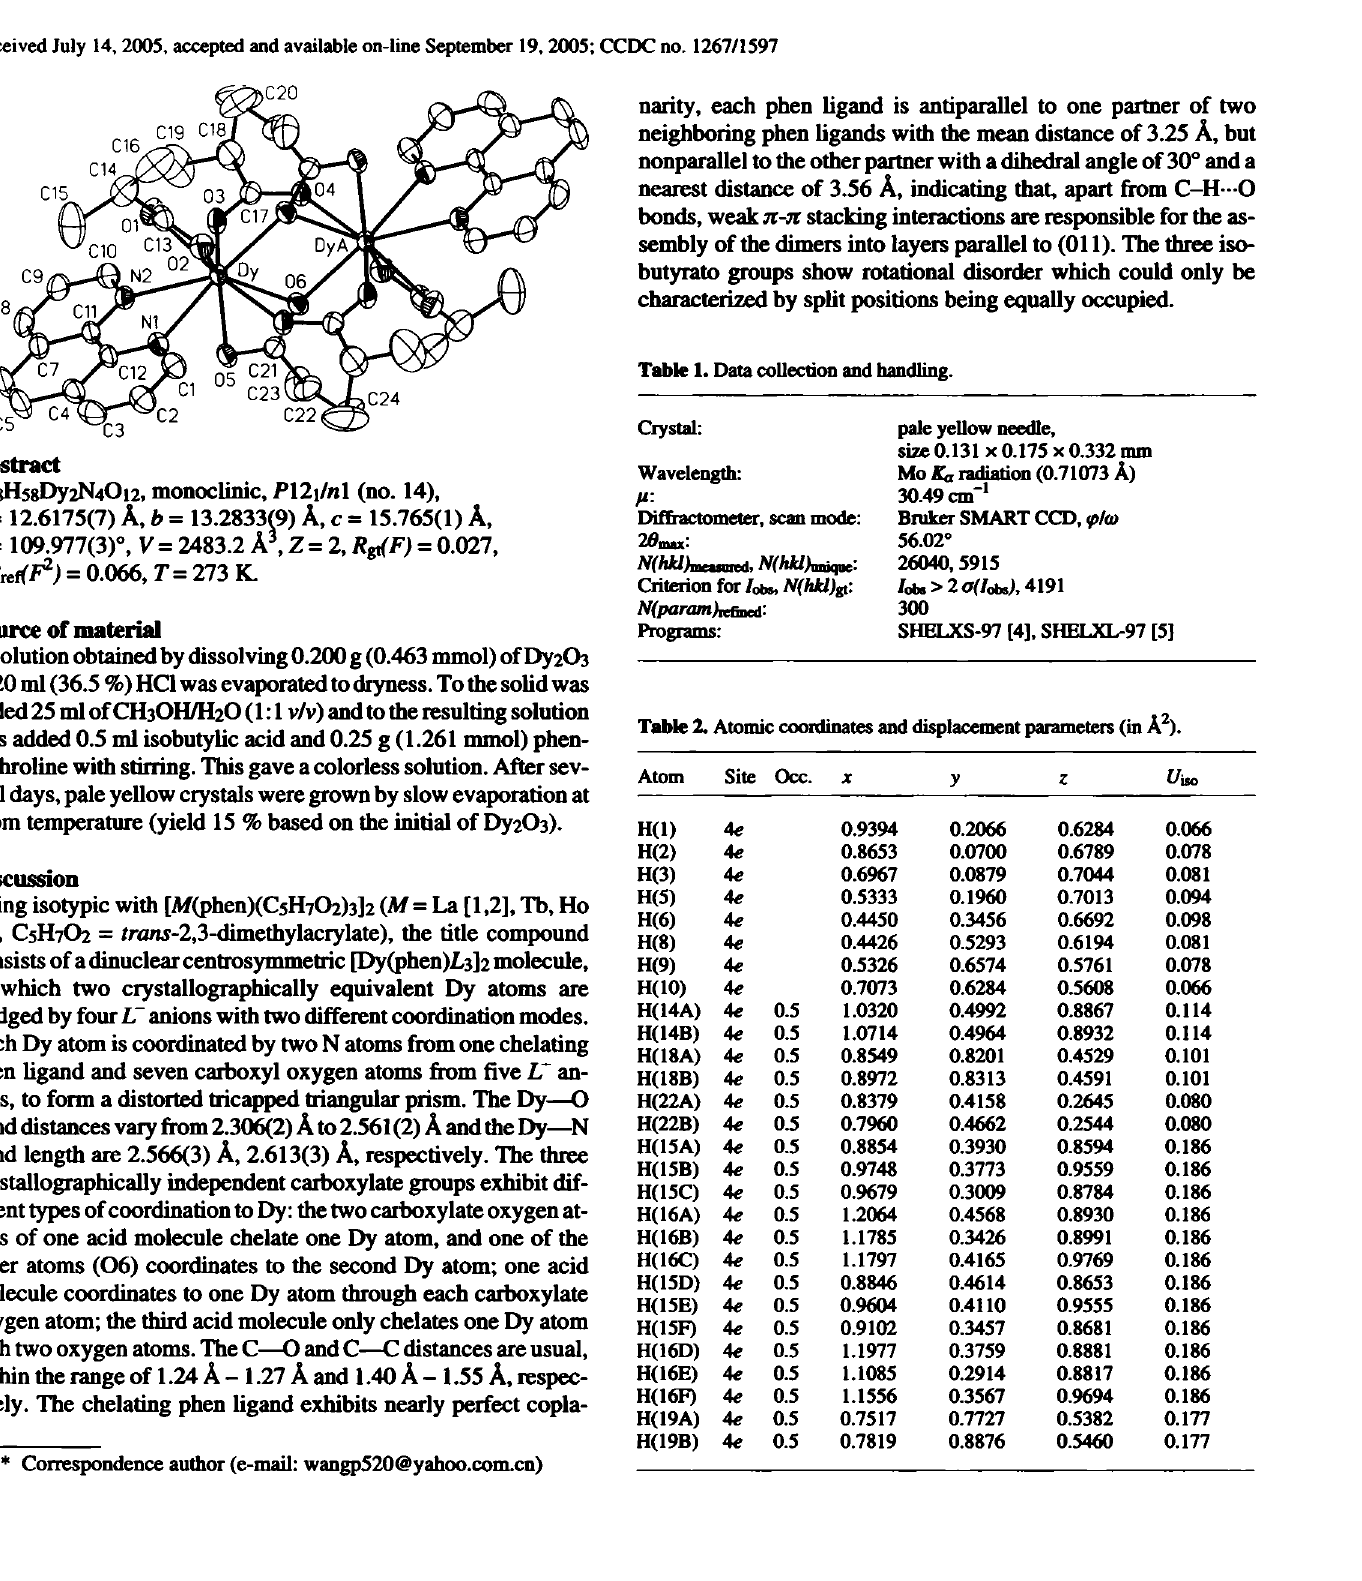
Table 1. Data collection and Handling